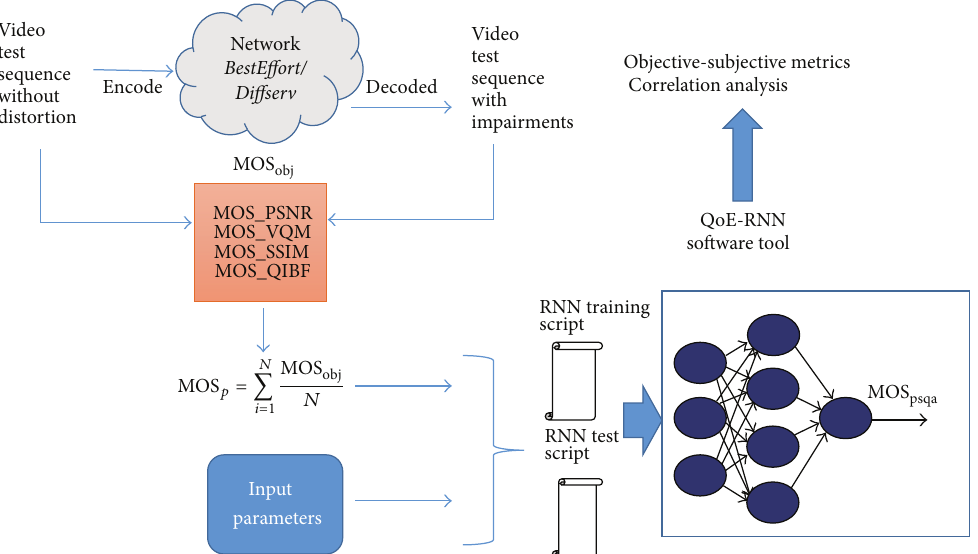
Figure 10: Employed methodology for the implementation of PSQA with the RNN.